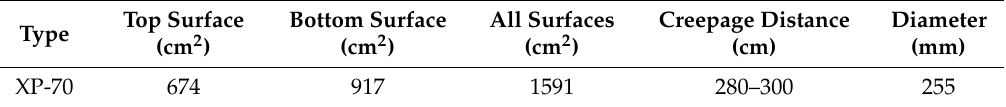
Table 1. Main parameters of the suspension glass insulator